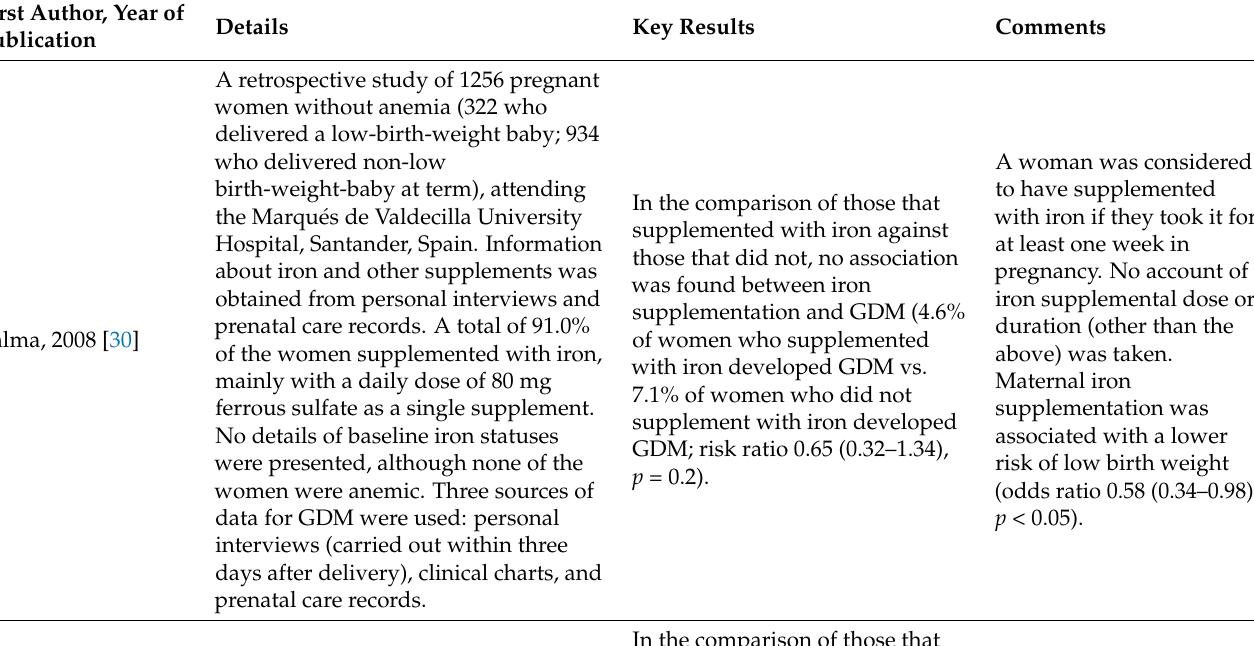
Table 3. Case–control studies that sought associations between iron supplementation in pregnancy and